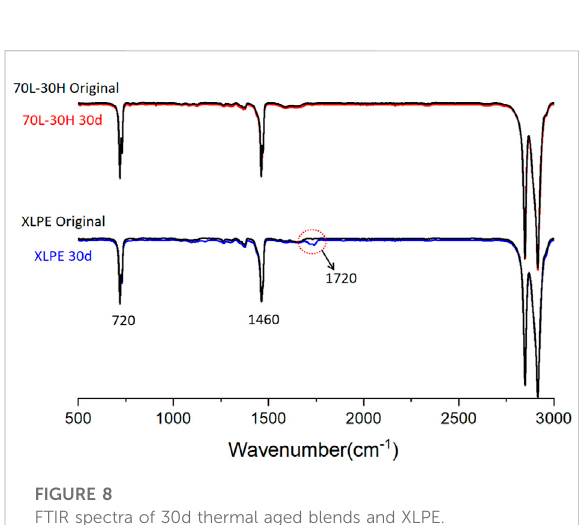
FIGURE 8 FTIR spectra of 30d thermal aged blends and